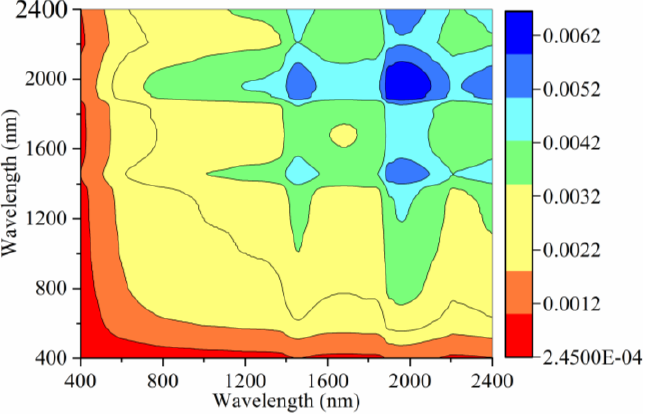
Figure 5. Two-dimensional synchronous correlation spectra of the mean reflectance at different SM levels (in the calibration dataset).